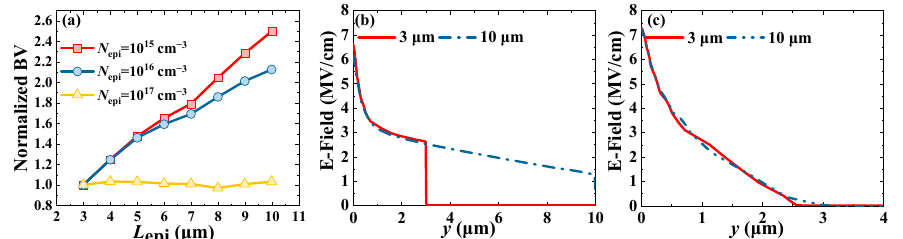
Figure 10. ( a ) At low concentrations, breakdown voltage grows as epitaxy thickness grows, and at high concentrations, breakdown voltage remains stable. ( b , c ) Vertical electric field profile at the breakdown of the device with different epitaxial thickness and ( b ) N epi = 10 15 cm − 3 and ( c ) N epi = 10 17 cm − 3 .